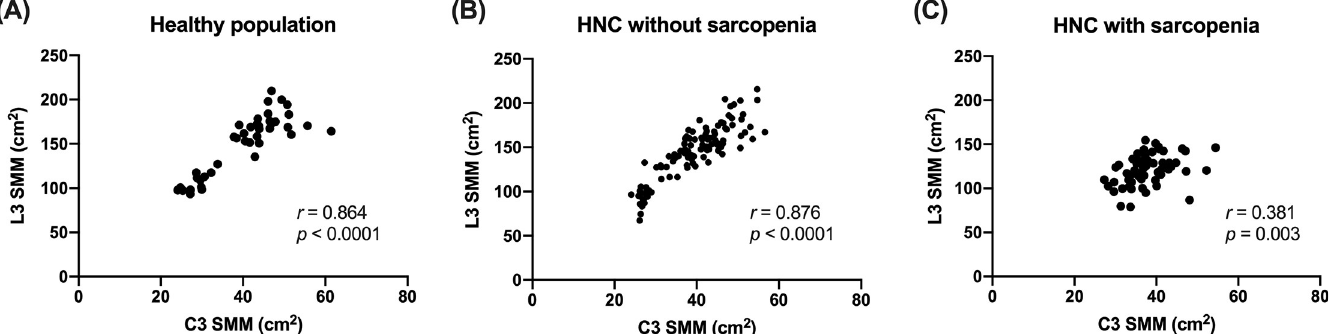
Fig 3. Association between the skeletal muscle mass at L3 and that at C3 in each group. SMM, skeletal muscle mass; HNC, head and neck cancer.